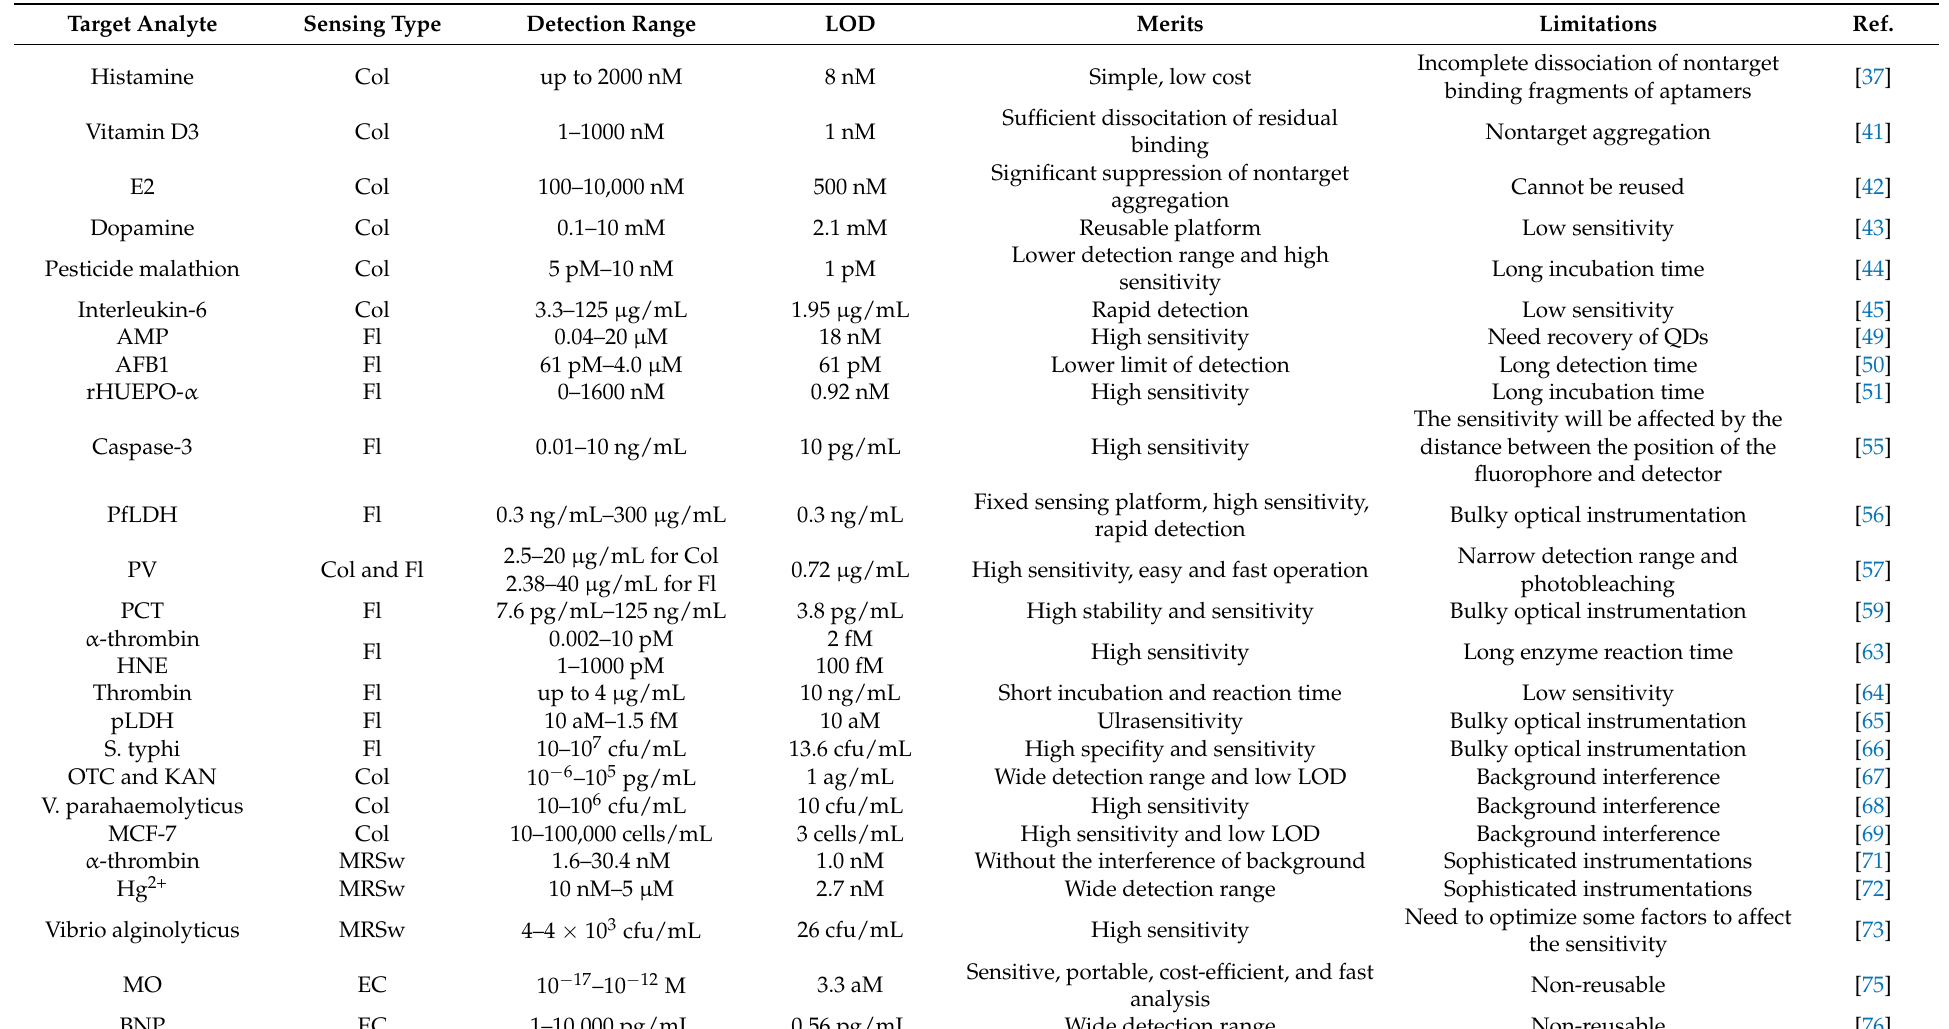
Table 1. Performance matrix of all the reviewed